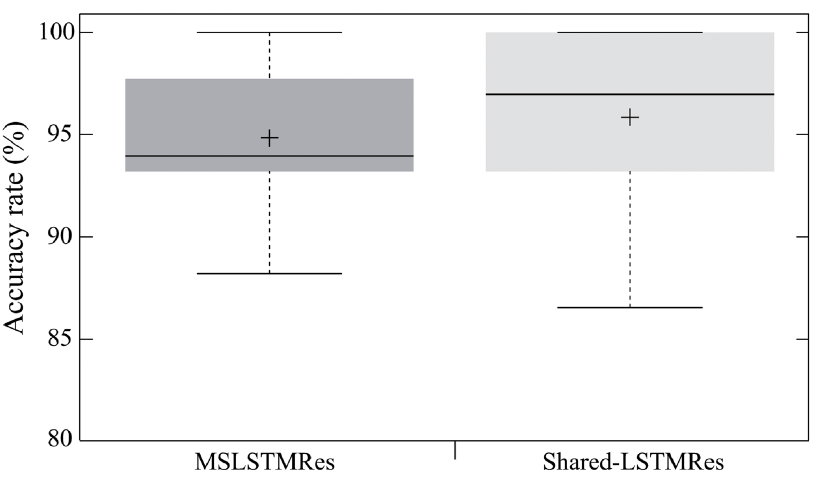
Fig 5. Average accuracy rate of the proposed model. Comparison between MSLSTMRes (94.69%) and MV-DNN (95.70%).